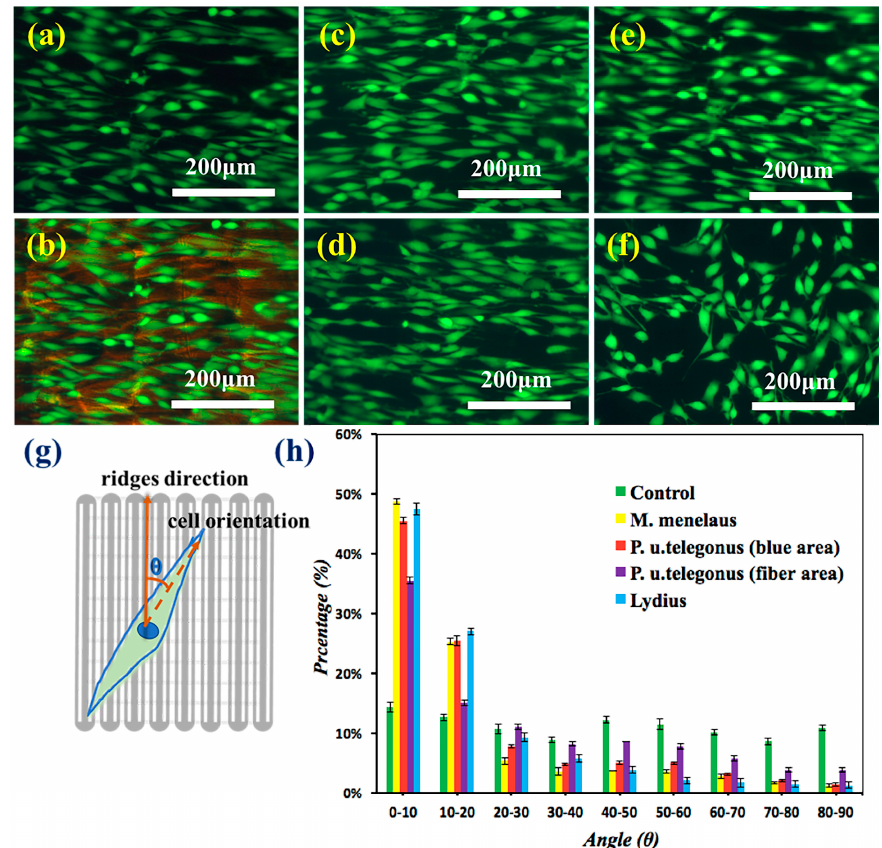
Figure 3. Fluorescence microscopy images of NIH-3T3 fibroblast cells cultured on different substrates after 48 h: ( a , b ) M. menelaus , ( c ) P. u. telegonus (blue region), ( d ) P. u. telegonus (fiber region), ( e ) O. c. lydius , and culture dish ( f ) as a control. 500 cells were measured on each substrate; ( g ) Schematic diagram of the orientation angle of the cells on the substrates, the dash line stands for the direction of cells orientation, the red arrows stands for the direction of grooves/ridges; and, ( h ) represents the frequency distribution of orientation angle of cells cultured on different substrates after 48 h. area of 500 cells were measured on each